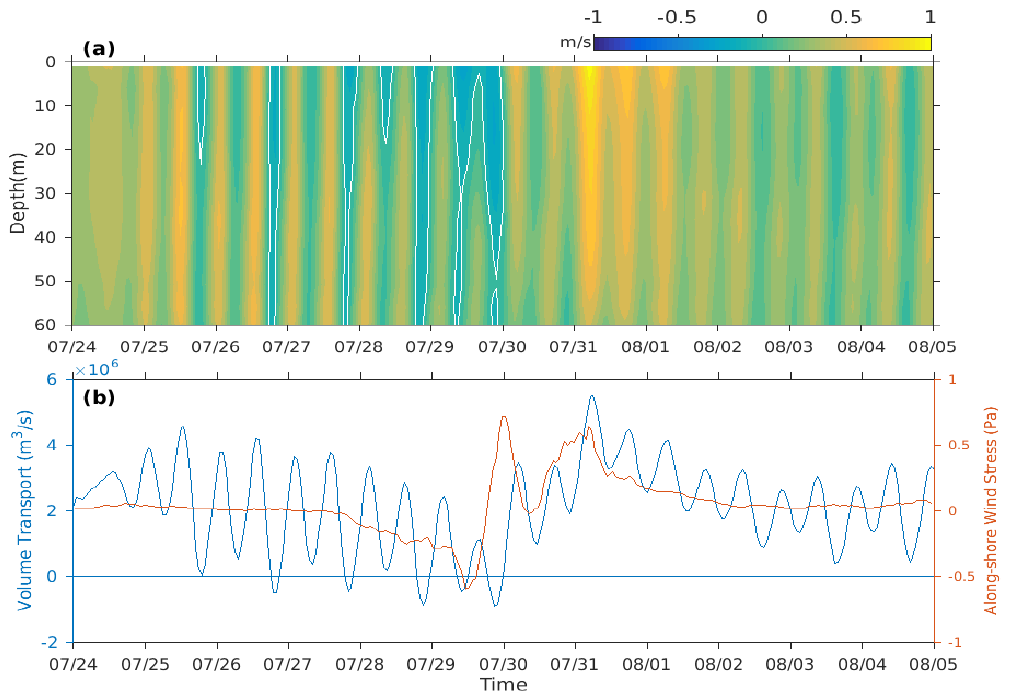
Figure 9. Averaged current velocity over time before, during, and after the passage of Typhoon Nesat, from the cross-section indicated in Figure 8f: ( a ) averaged along-shore velocity changes with time and depth, ( b ) time series of volume transport through the same cross-section (blue line) and cross-section averaged surface along-shore wind stress (red line).